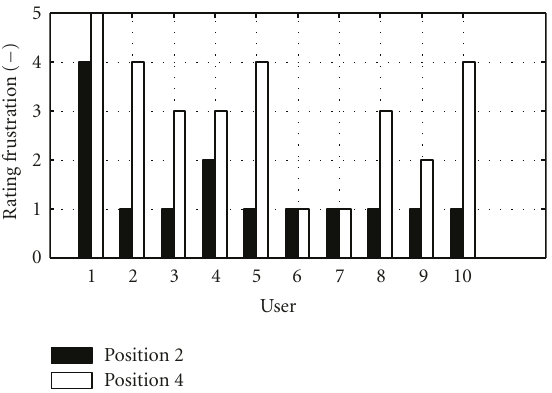
Figure 7: Comparison of ratings of frustration (Q4) for all users at location 2 ( P = − 61dBm) and at location 4 ( P = − 83 dBm).